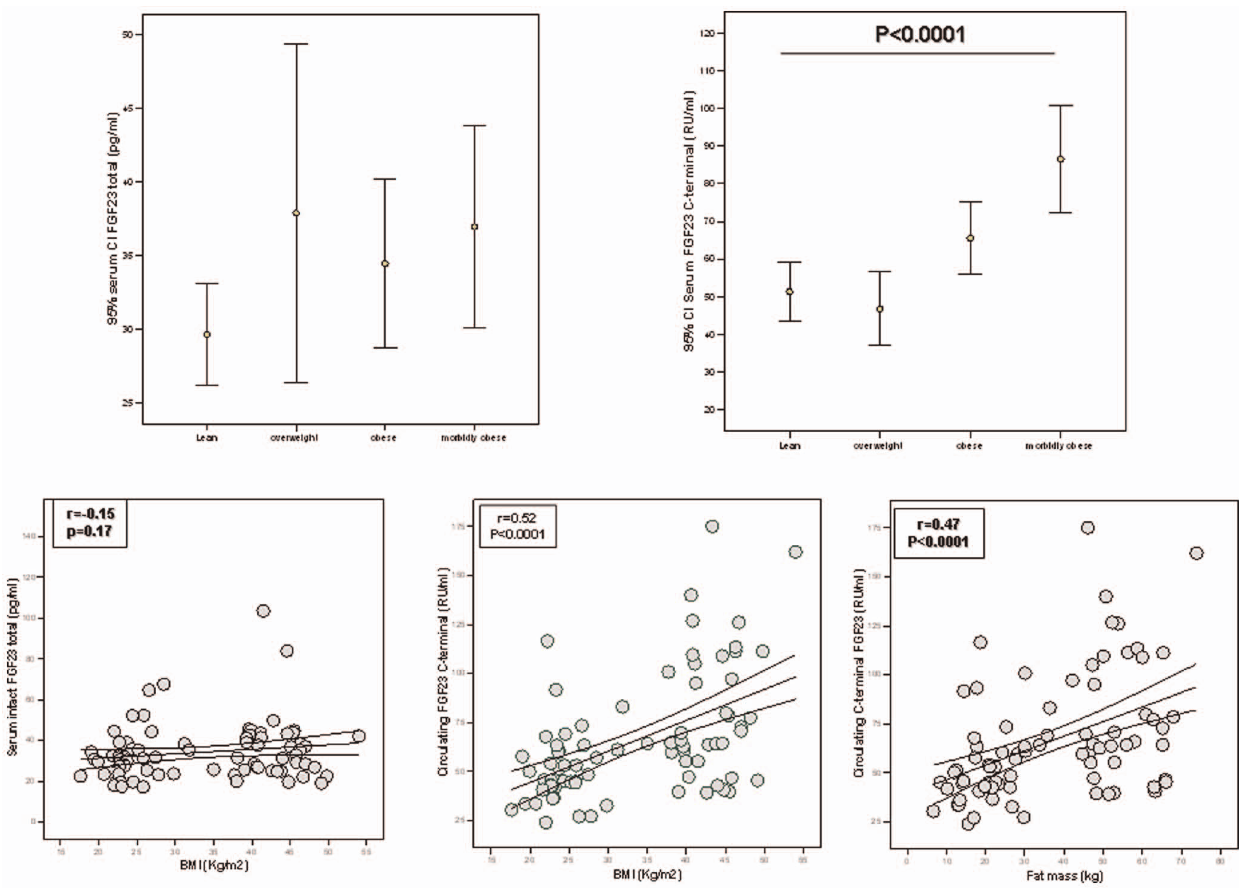
Figure 2. FGF-23 associations with insulin sensitivity. a) Linear association analysis between serum intact FGF-23 concentration and insulin sensitivity in subjects from cohort 1; b) Linear association analysis between serum C-terminal FGF-23 concentration and insulin sensitivity in subjects from cohort 1.